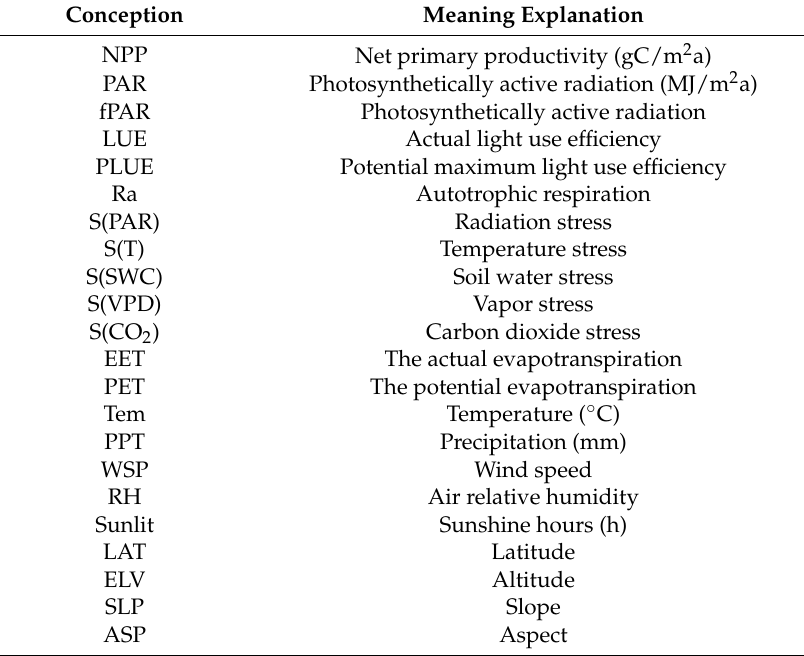
Table 2. The key conceptions and parameters in the framework of model.